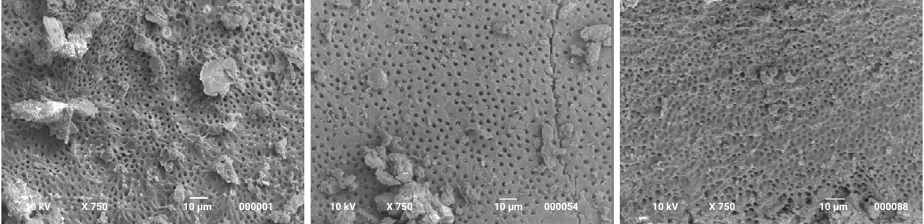
Figure 6. SEM images (magnification 750x) of precipitate formation in the apical third of several specimens, but in smaller